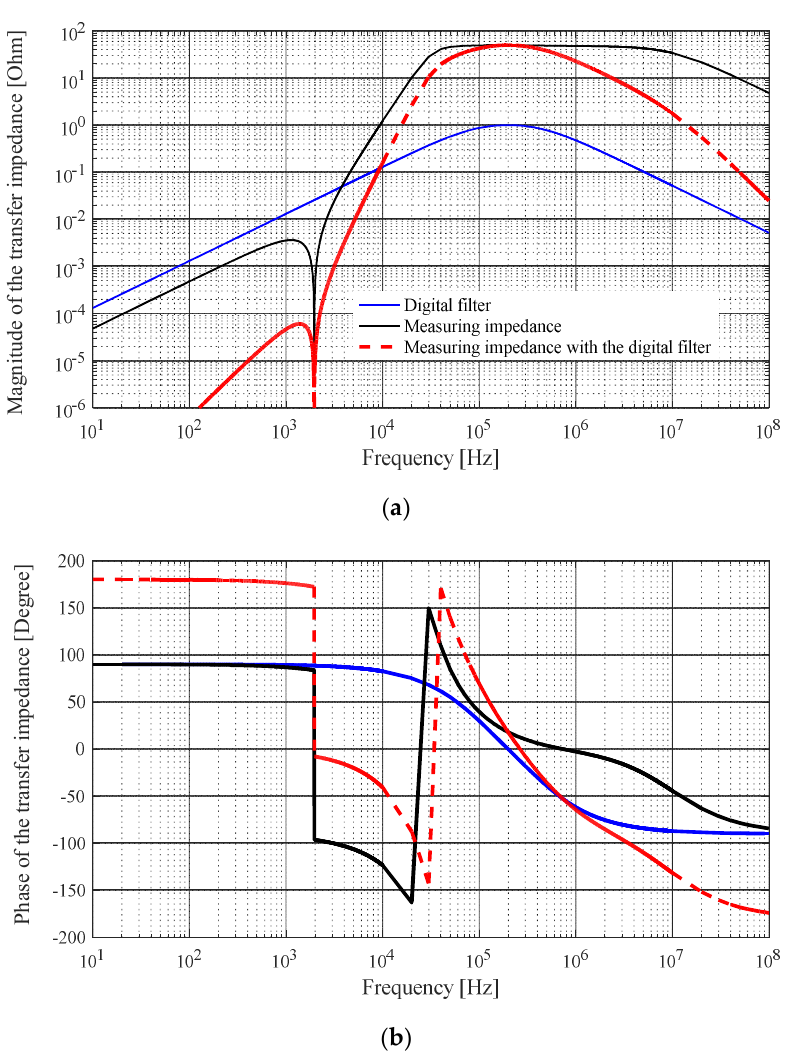
Figure 5. Transfer impedance in the frequency domain of the measuring impedance: ( a ) magnitude; ( b ) phase angle (degree).